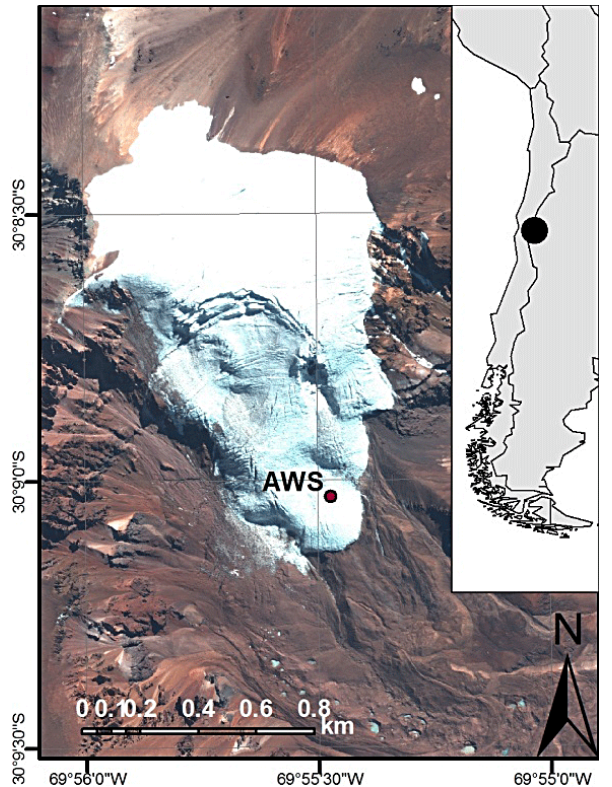
Figure 2. Illustration of the four experiments over different pen- itente surface topographies during the 2012/2013 ablation season. Details for each experiment are listed in Table